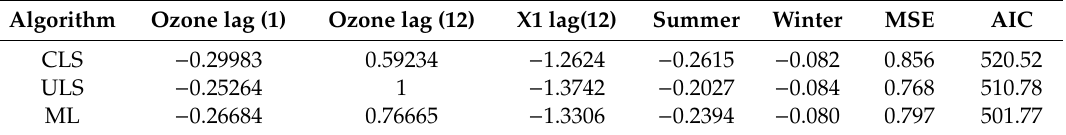
Table 2. Parameter estimates and fit statistics (mean square error (MSE), and Akaike Information Criterion (AIC)) of the ARIMA (autoregressive integrated moving average) model with three di ff erent algorithms of the ARIMA process. CLS—conditional least square; ULS—unconditional least square; ML—maximum